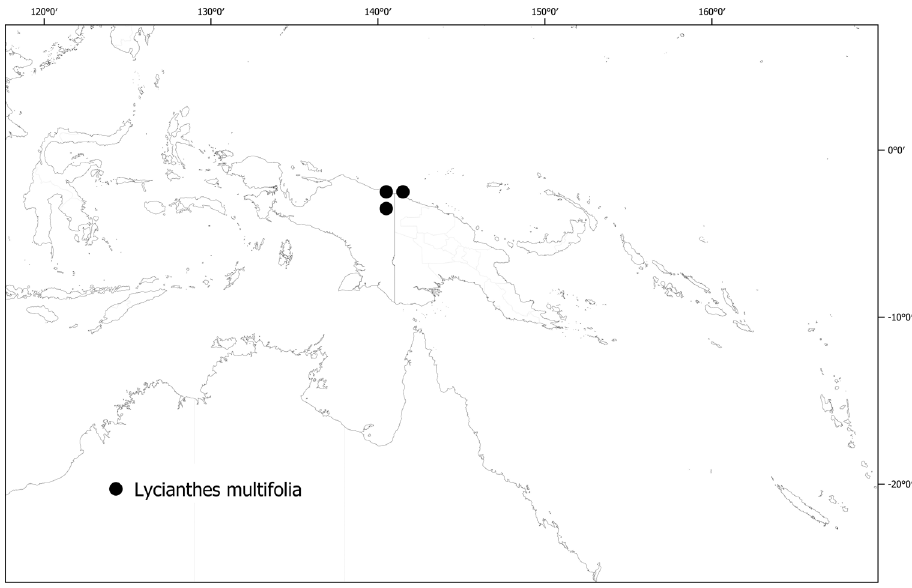
Figure 36. Distribution of Lycianthes multifolia